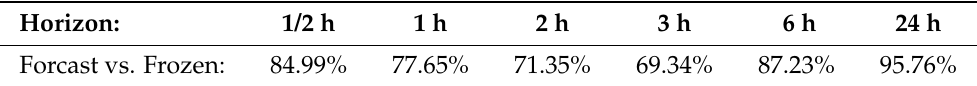
Table 3. Forecast vs. frozen (% RMSE) for the tangent